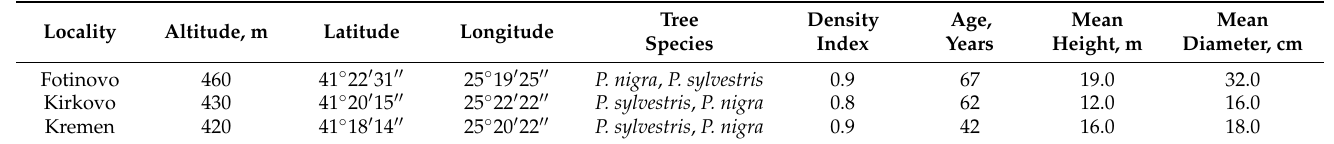
Table 1. Main characteristics of studied pine